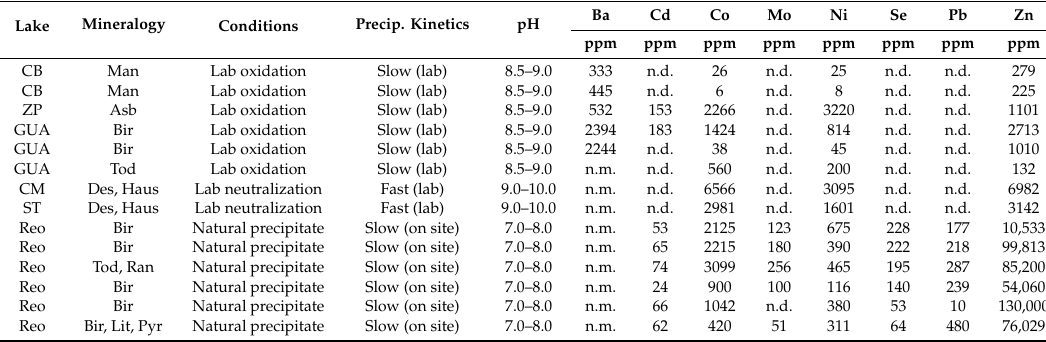
Table 3. Mineralogy (as deduced by XRD and SEM–EDX), pH range of precipitation, and trace metal content (as measured by ICP-AES, AAS, and / or ICP-MS) of Mn oxides formed by Mn(II) oxidation in Mn-rich waters from di ff erent Spanish mine pit lakes (on site or in the lab). Data for natural precipitates found in Reoc í n pit lake were taken from